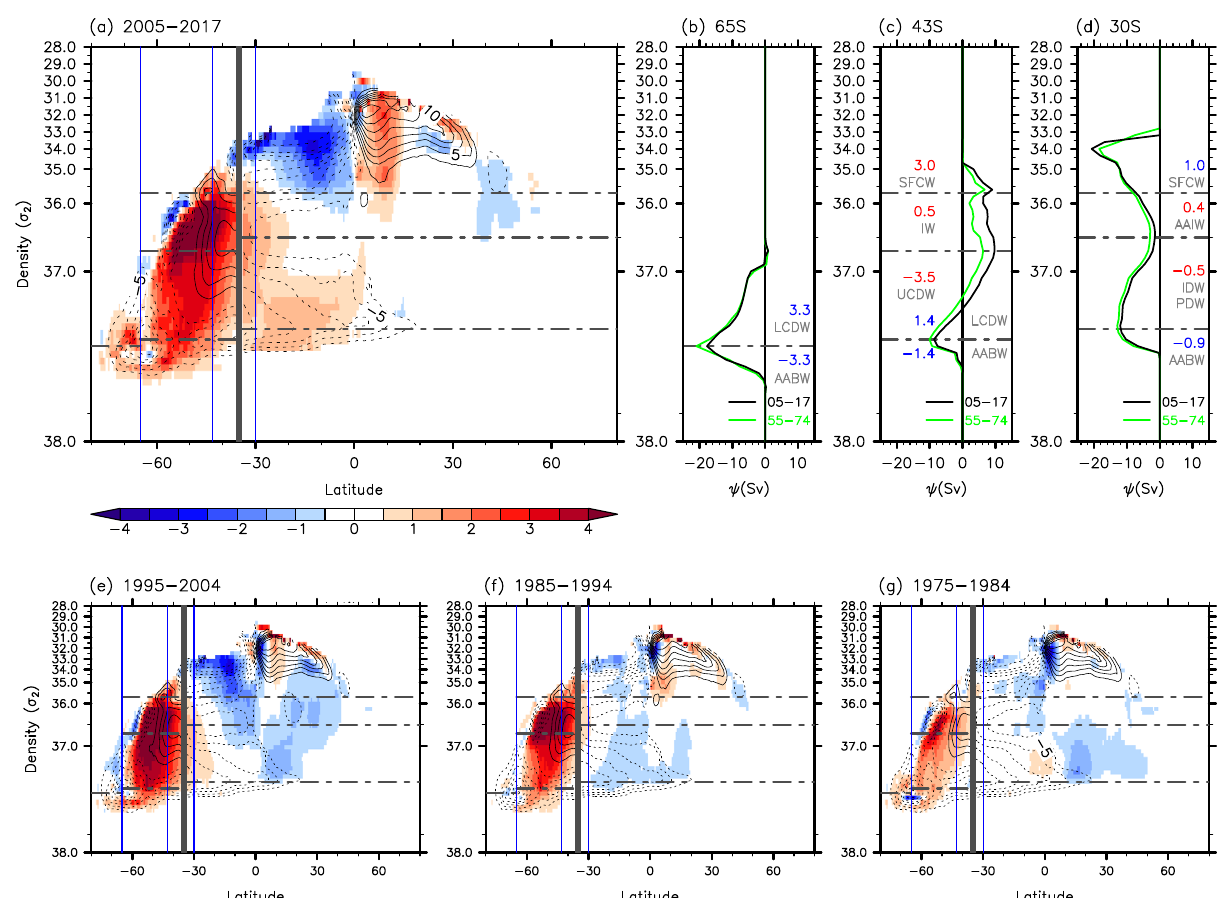
Fig. 1 The GMOC and its interdecadal changes in the Indo-Paci fi c and Southern Oceans. The GMOC volume transport streamfunction (contours) in the Southern Ocean (south of 35°S) and the Indo-Paci fi c Ocean (north of 35°S) and its changes (shades) during a 2005 – 2007, e 1995 – 2004, f 1985 – 1994, and g 1975 – 1984 in reference to the base period of 1955 – 1974. The GMOC volume transport streamfunction at b 65°S and c 43°S in the Southern Ocean, and at d 30°S in the Indo-Paci fi c Ocean during 2005 – 2007 (black lines) and 1955 – 1974 (green lines). The vertical axis is potential density in reference to 2000m ( σ 2 units). The differences in GMOC volume transport values between 2005 – 2017 and 1955 – 1975 for SFCW, AAIW, IW, UCDW, LCDW, IDW & PDW and AABW are shown at b 65°S, c 43°S, and d 30°S. Red colored values are for the increased transport values, and blue colored are for the decreased volume transport values. Black-dotted lines indicate the density ranges of water masses. Volume transports are in Sv